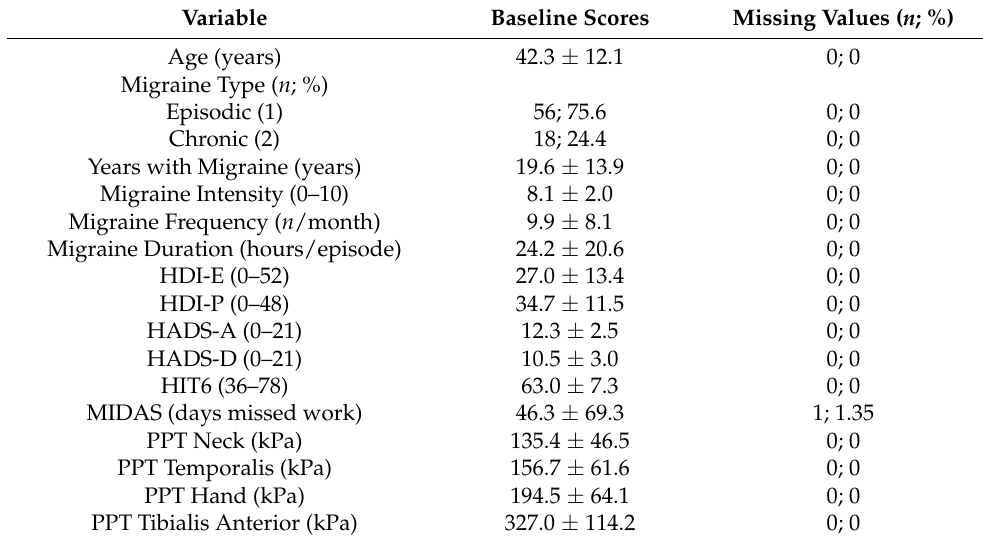
HADS: Hospital Anxiety and Depression Scale; HDI: Headache Disability Index; HIT: Headache Impact Test; MIDAS: Migraine Disability Assessment Scale; PPT: Pressure Pain Thresholds.